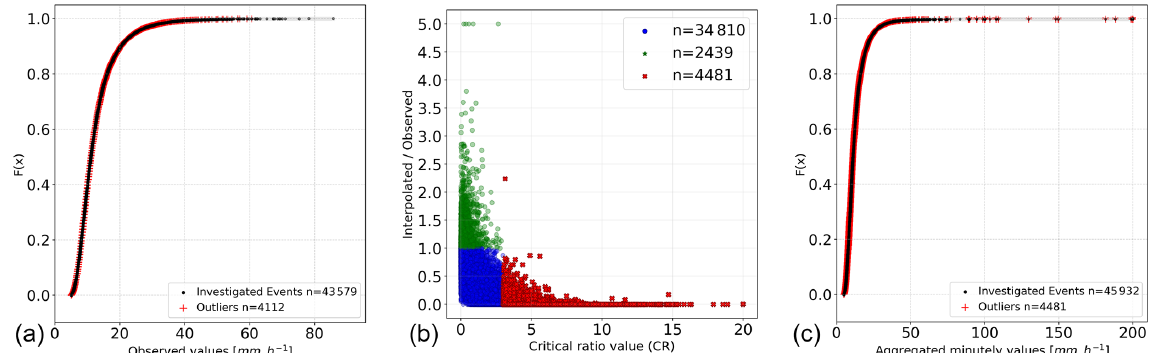
Figure 3. Panel (a) shows the CDF of all investigated hourly events, with the detected outliers marked in red. Panel (b) shows, for the data aggregated at every minute, the CR values versus the ratio of interpolated and observed hourly values. Panel (c) shows the CDF of all investigated hourly events, with the detected outliers marked in red. The hourly data in the center and right panels were aggregated from the minute values. Note that an upper limit of 200mmh − 1 was set.